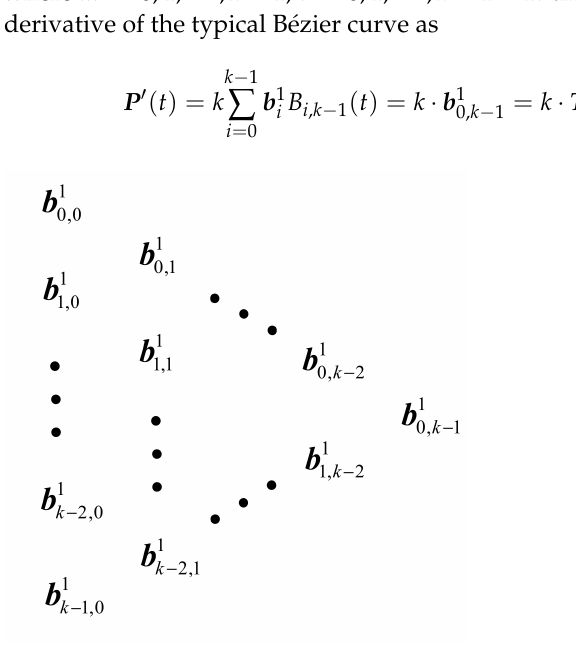
Figure 7. The de Casteljau algorithm of P (cid:48) ( t )